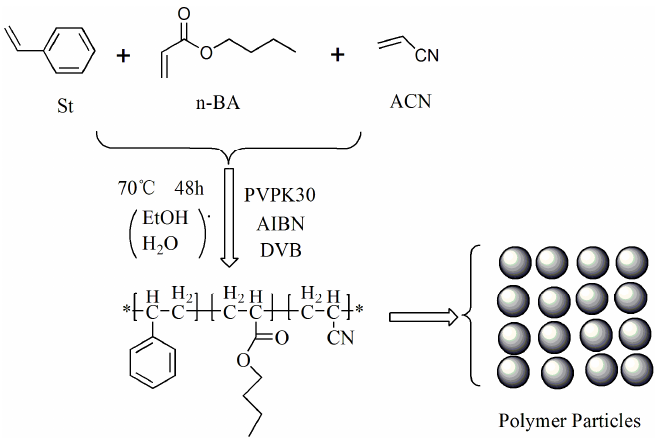
Figure 1. The synthesis process of the polymer particle adhesive. Table 1. The synthetic formula of polymer particle adhesive.